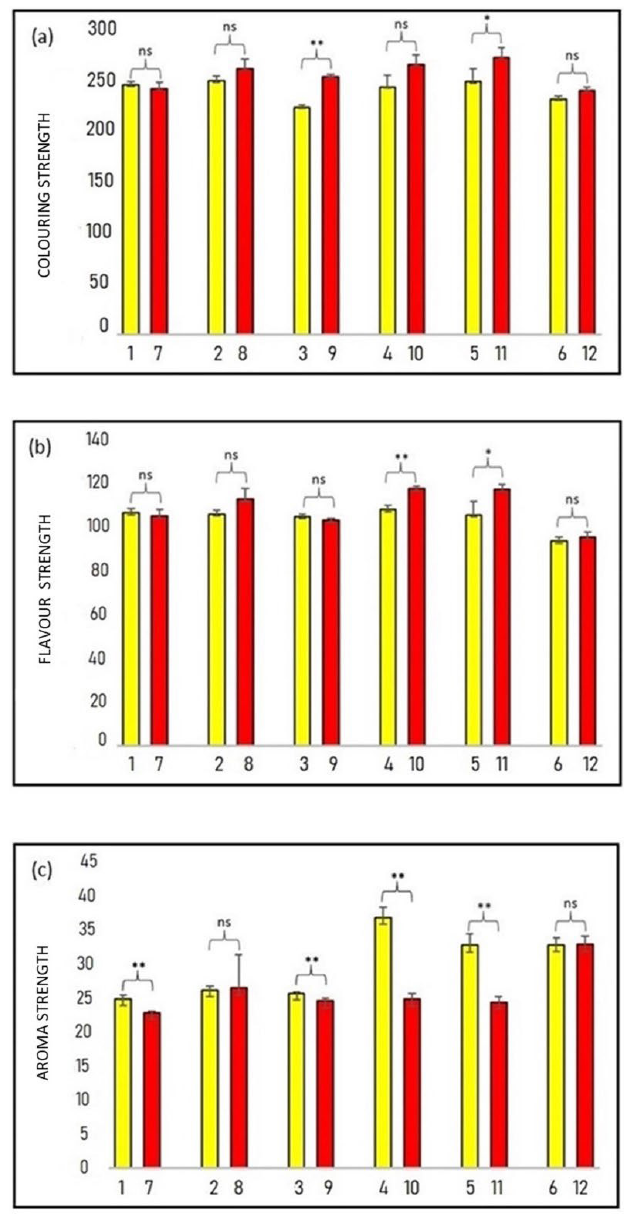
Fig. 4: Quality parameters of saffron samples: (a) colour (b) flavour (c) aro - ma strength of saffron collected blossomed after some hours of light exposure (yellow) and collected in bud early in the morning (red). Key: *, significantly different (p <0.05); **, very significantly differ - ent (p < 0.01); ns, not significantly different. Numbers are the codes of samples and samples coupled are from same field (same grower).